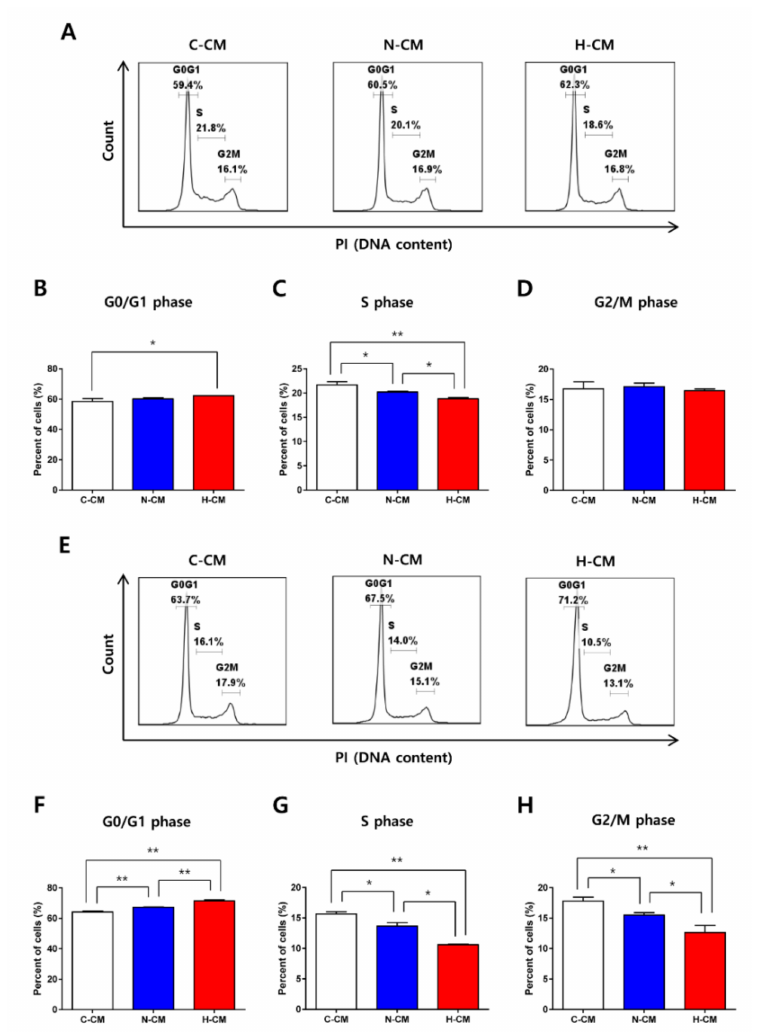
Figure 2. H-CM strongly induced cell cycle arrest in HeLa cells. The percentage of HeLa cells in the G0/G1 phase ( A , B ), S phase ( A , C ), and G2/M phase ( A , D ) after 24 h of treatment with C-CM, N-CM, or H-CM. The percentage of HeLa cells in the G0/G1 phase ( E , F ), S phase ( E , G ), and G2/M phase ( E , H ) treated for 48 h with C-CM, N-CM, or H-CM. The cells were incubated with C-CM, N-CM, or H-CM for 24 h or 48 h, and the cell cycle was analyzed using PI staining and flow cytometry. Data are expressed as the mean ± SD experiments performed in triplicate (each group n = 3, * p < 0.05, ** p < 0.01, one-way ANOVA). C-CM, serum-free medium as control; N-CM, conditioned medium from normoxic HDFs; H-CM, conditioned medium from hypoxic HDFs; PI, propidium iodide. Images ( A , E ) were produced using FlowJo v10 (Treestar). Images ( B – D , F – H ) were produced using GraphPad Prism version 7.00 (GraphPad